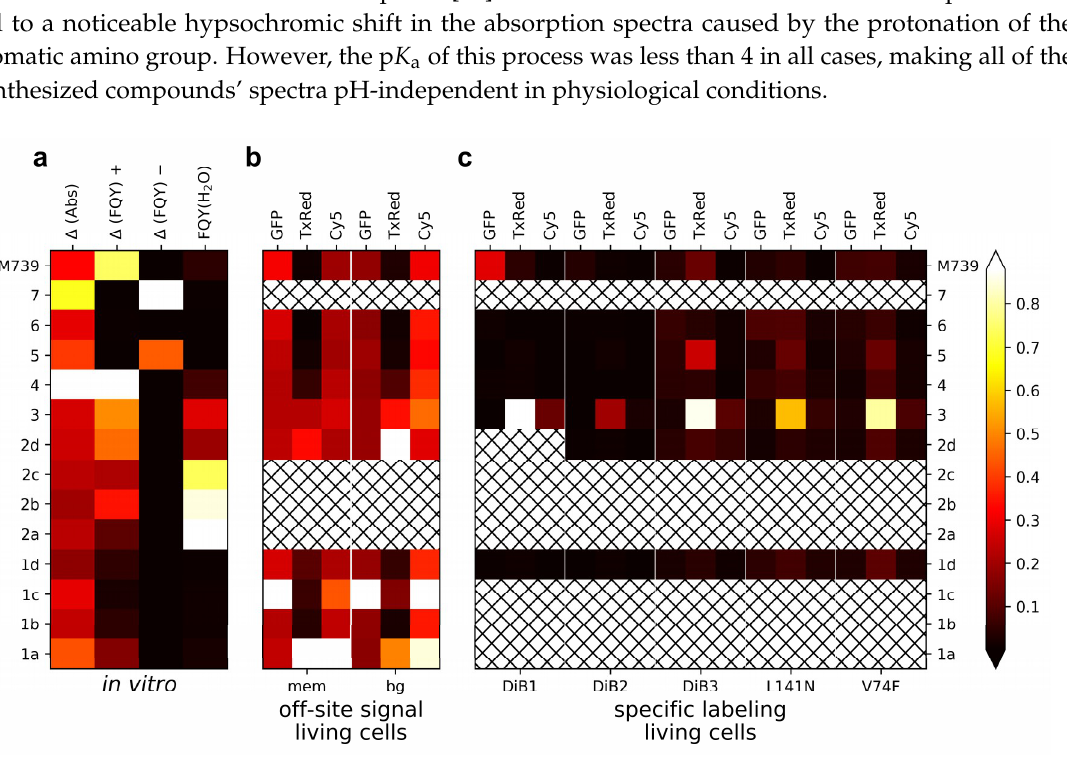
Figure 1. Fluorogenic compounds screening pipeline. The values are normalized column-wise and depicted in pseudocolor. Regions with no data are hatched. ( a ) In vitro screening (see also ESI Table S1): Δ(Abs)—maximum change in absorbance maxima position, relative to water; Δ(FQY)+— maximum increase in fluorescence quantum yield, relative to water; Δ(FQY)—maximum decrease in fluorescence quantum yield, relative to water; FQY(H 2 O)—fluorescence quantum yield in water. ( b ) Off-site signal and background in HeLa cells: Mem-signal in membranes, bg—signal in the imaging media. ( c ) Specific labeling in HEK293 cells expressing H2B-fusions of lipocalin mutants.